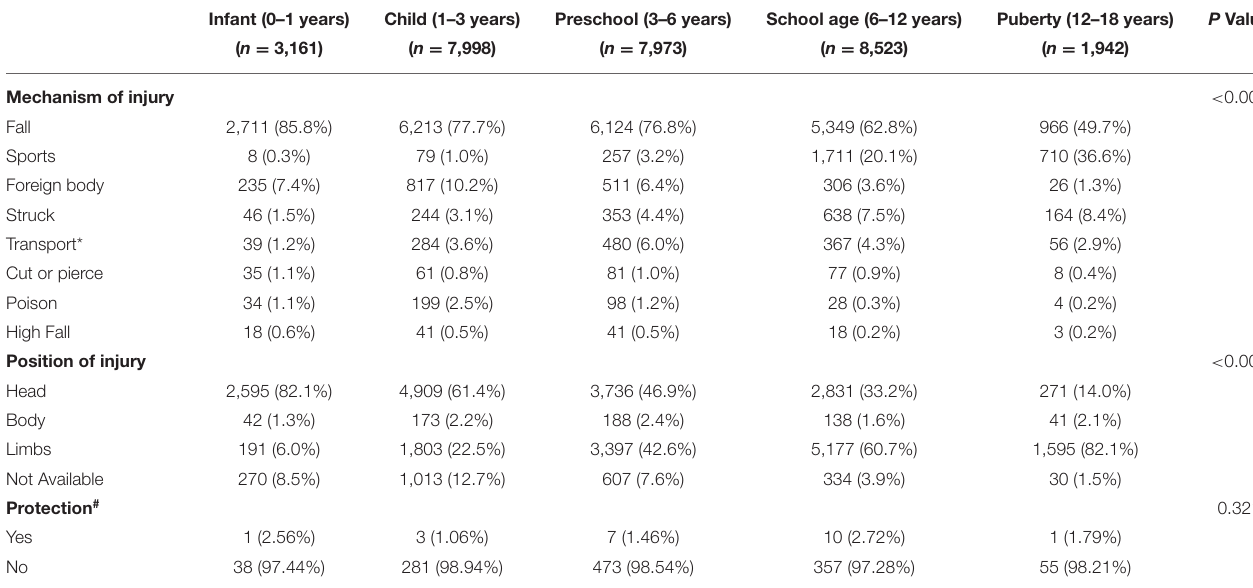
TABLE 4 | Mechanism of child unintentional injury in the emergency department by